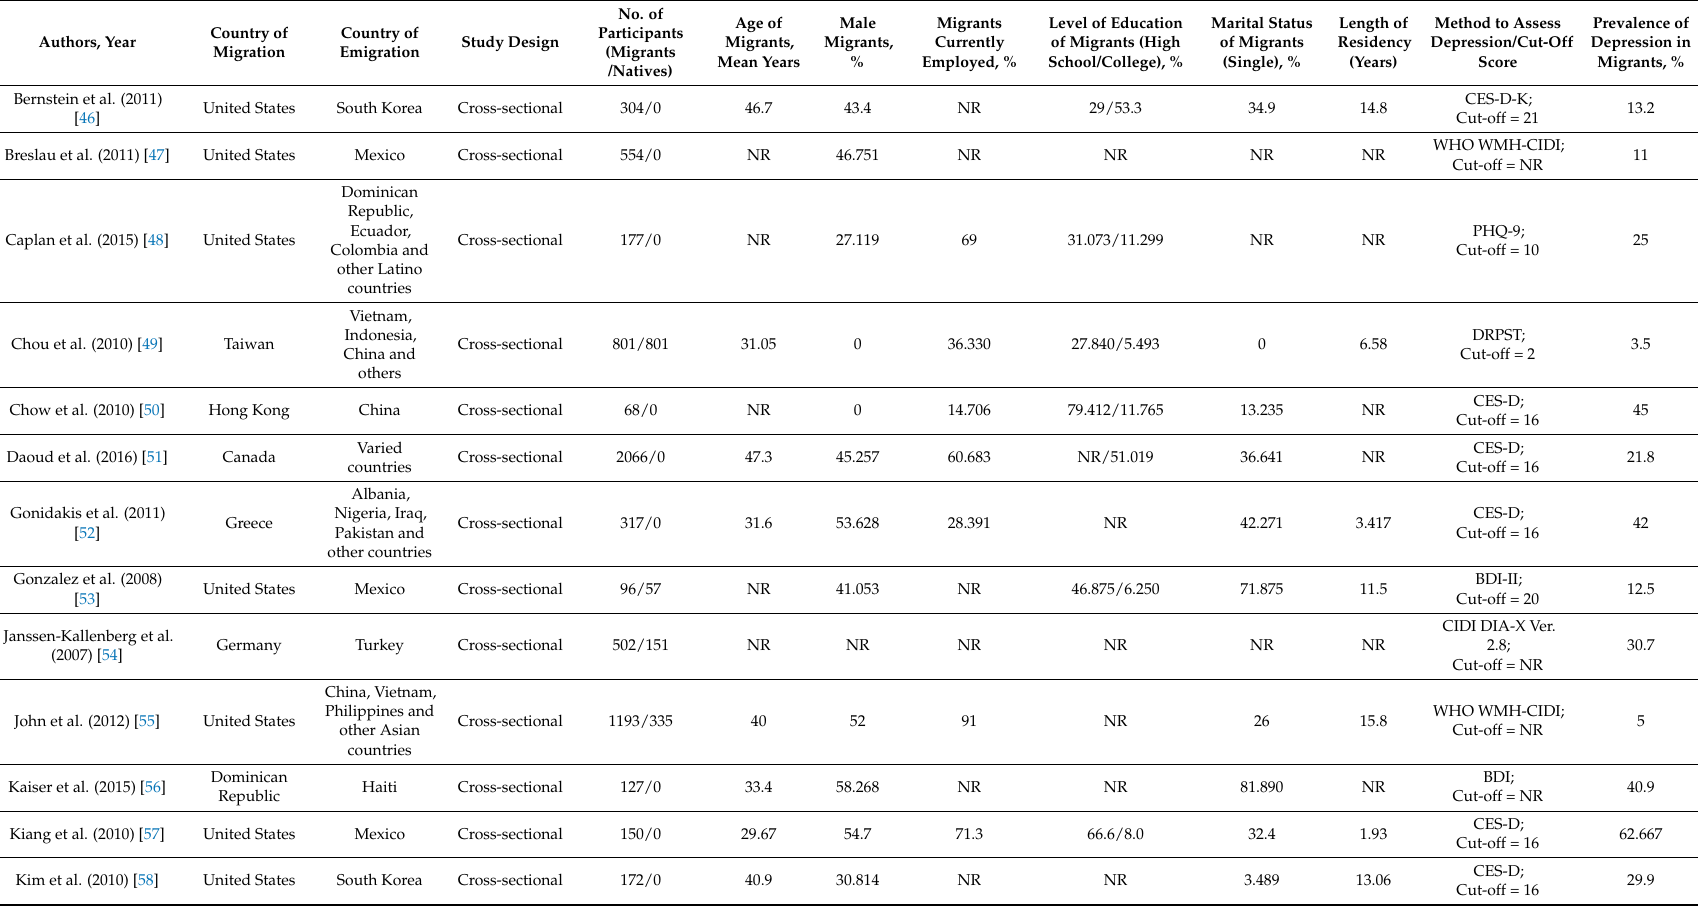
Table A1. Descriptive data of the 25 included studies for